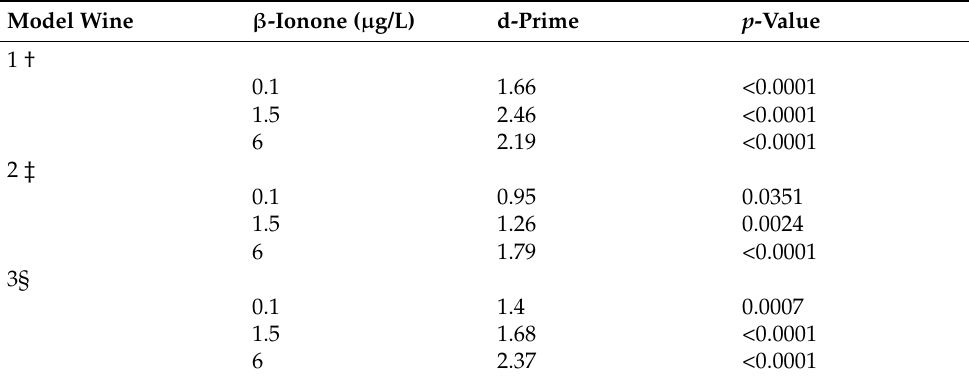
Table 1. p -values for β -ionone concentration calculated with signal detection theory.